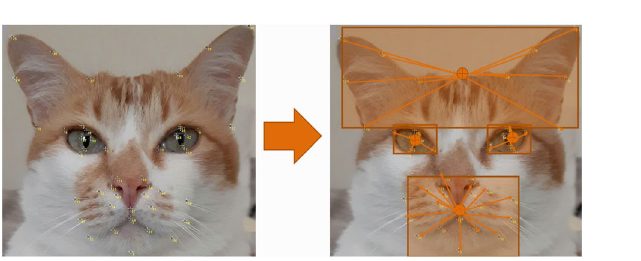
Figure 3. Landmark transformation into vectors, and division into four regions of interest according to the Felice Grimace Scale.